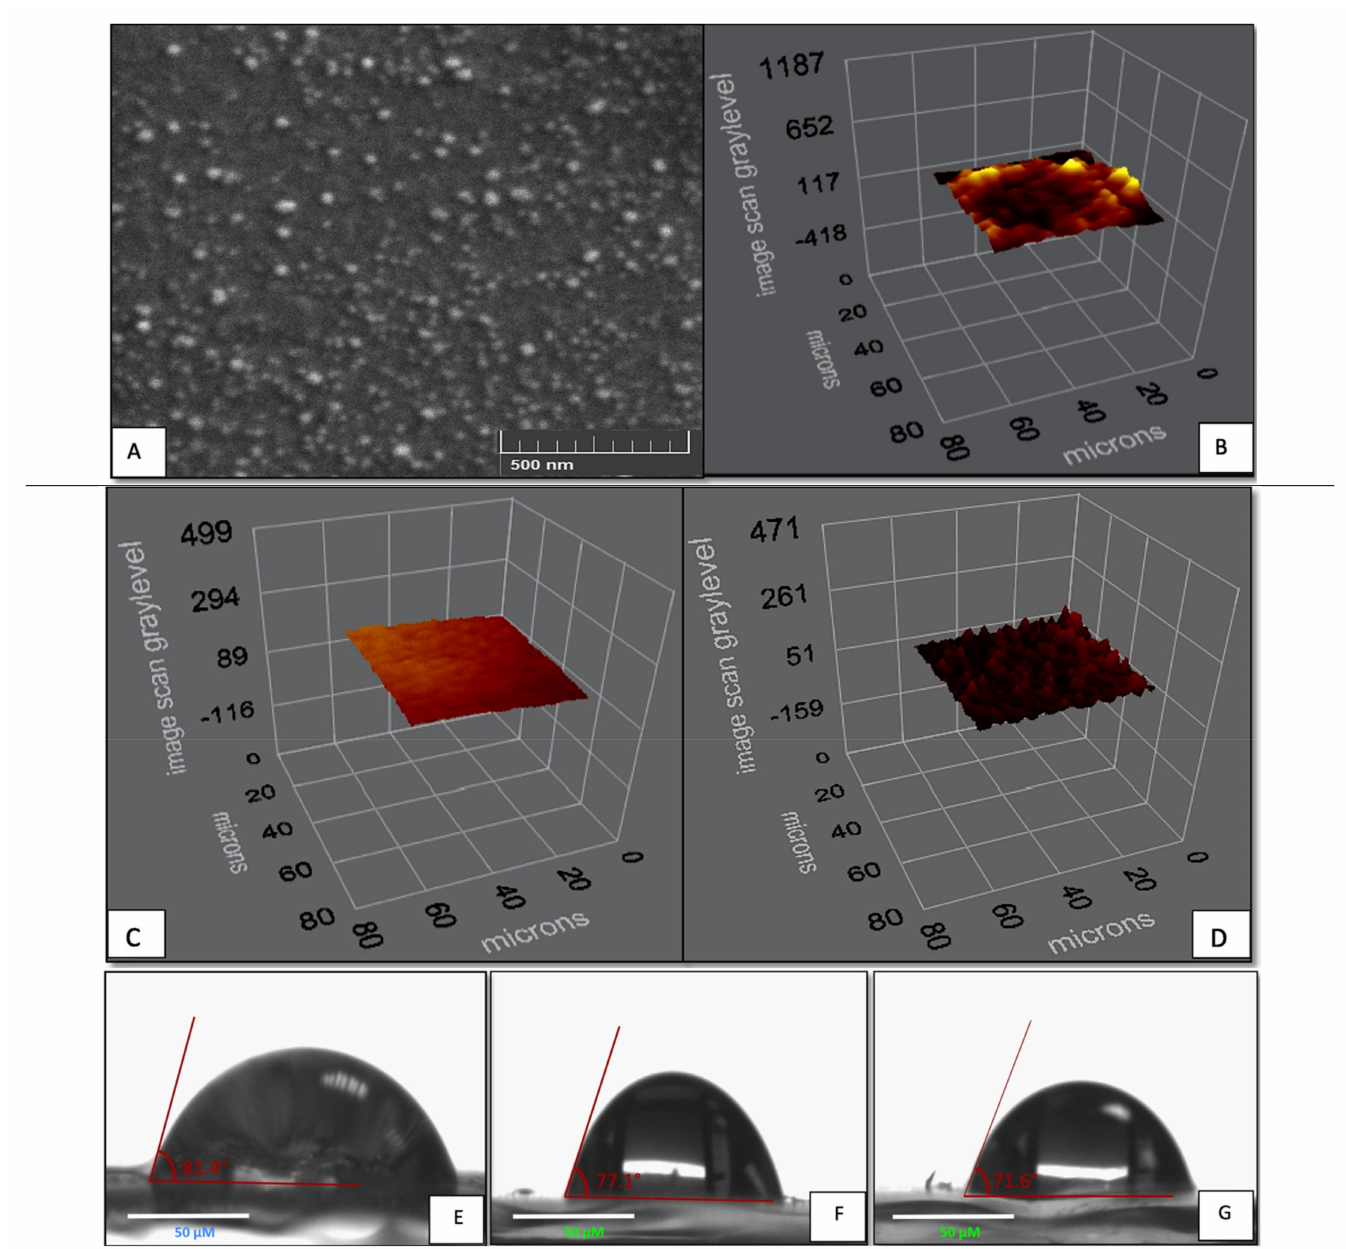
Figure 2. The SEM image ( A ) and the ellipsometer measurements of I-SPR sensor ( B ), 1,8-octanedithiol modified SPR chip ( C ), and P-SPR sensor ( D ), and CA measurements of the bare SPR chip ( E ), P-SPR sensor ( F ) and I-SPR sensor surfaces ( G